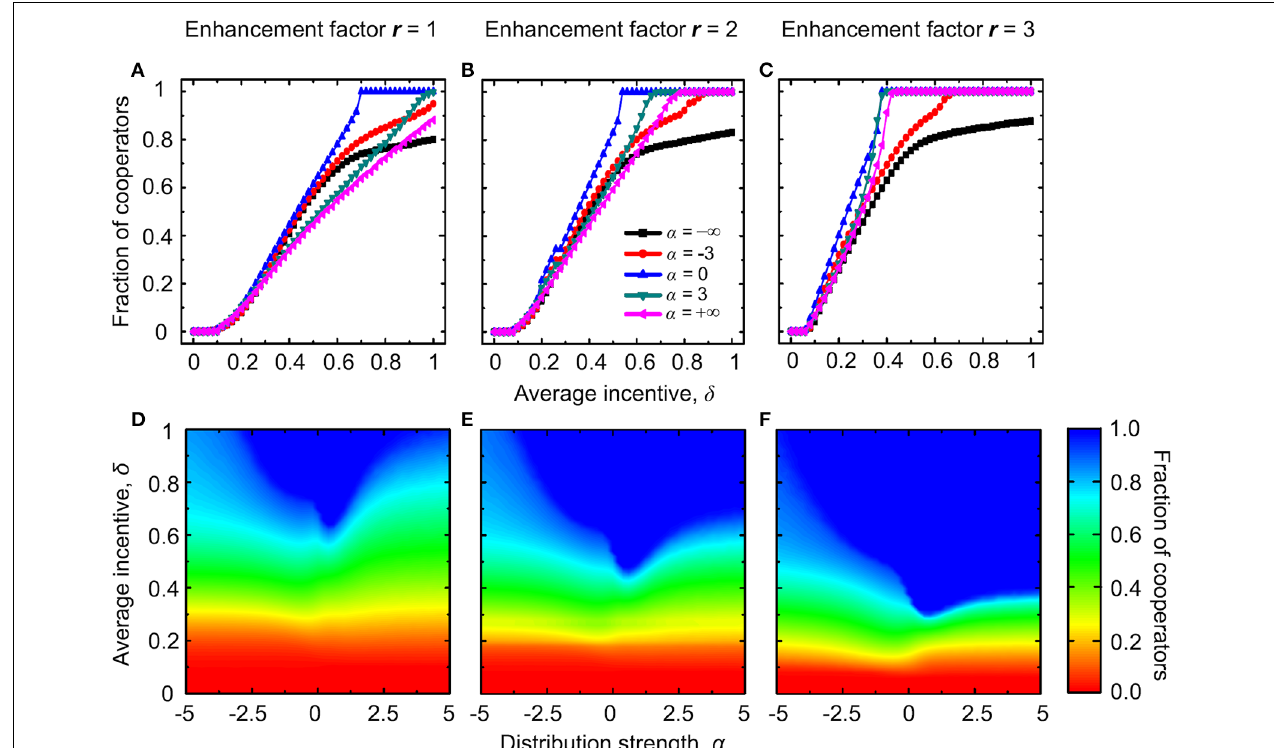
FIGURE 7 | Evolution of cooperation with institutional rewarding and degree-normalized payoffs. Top row depicts the stationary fraction of cooperators as a function of the average amount of available incentives δ for different values of the distribution strength α . The enhancement